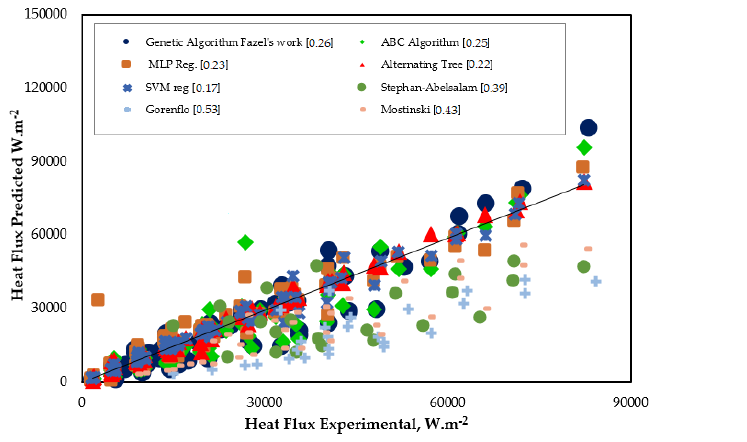
Figure 9. Comparison of some well-known correlation and computational intelligence